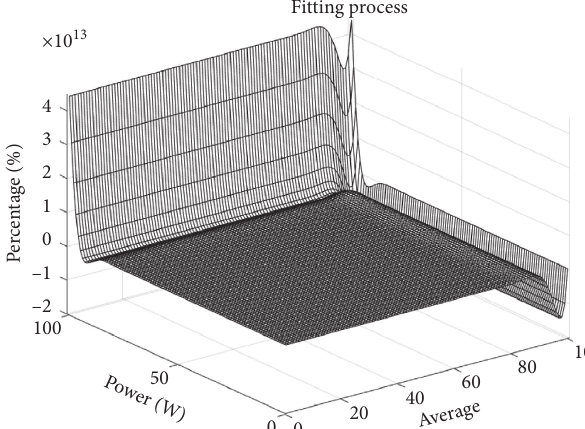
Figure 7: Training process